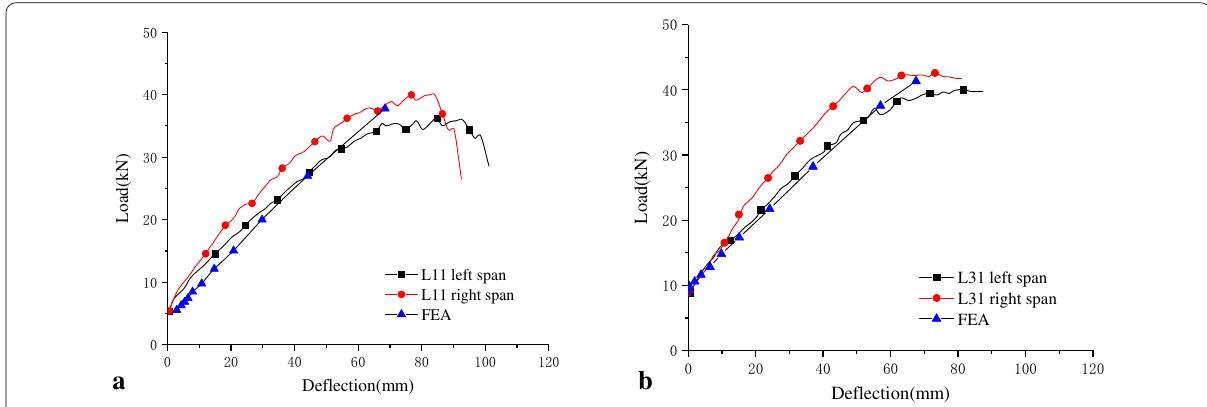
Fig. 17 Comparison of FEA and test results. a Control 18%; b Control 30%